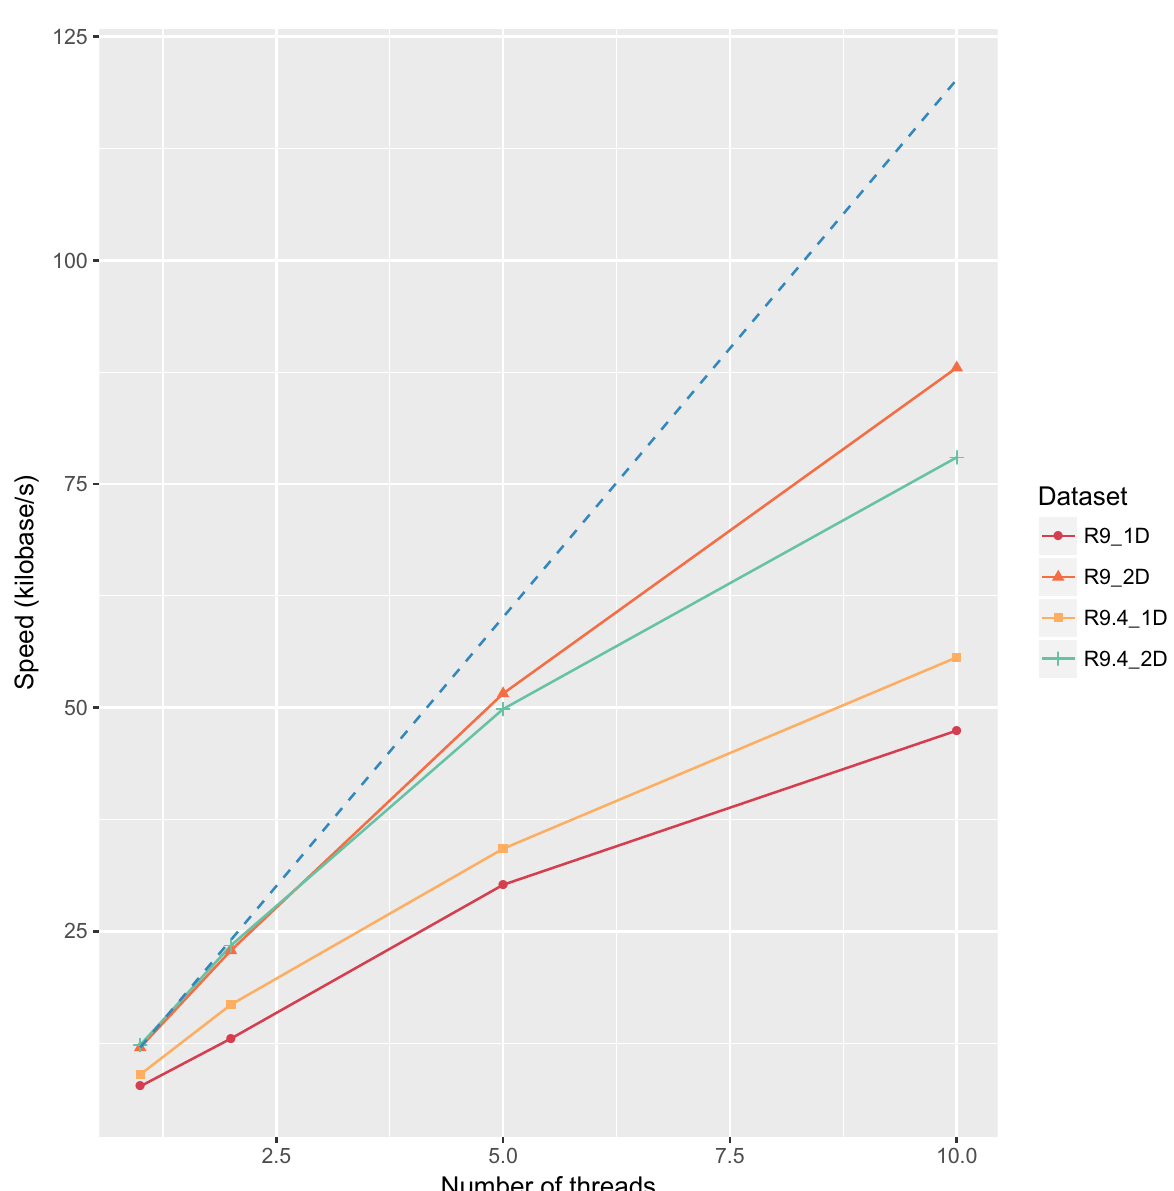
Figure 3. Speed of deep lossless compression of FAST5 files using multiple threads. The dotted blue line shows the theoretical linear maximum increase in speed for the R9 2D run.